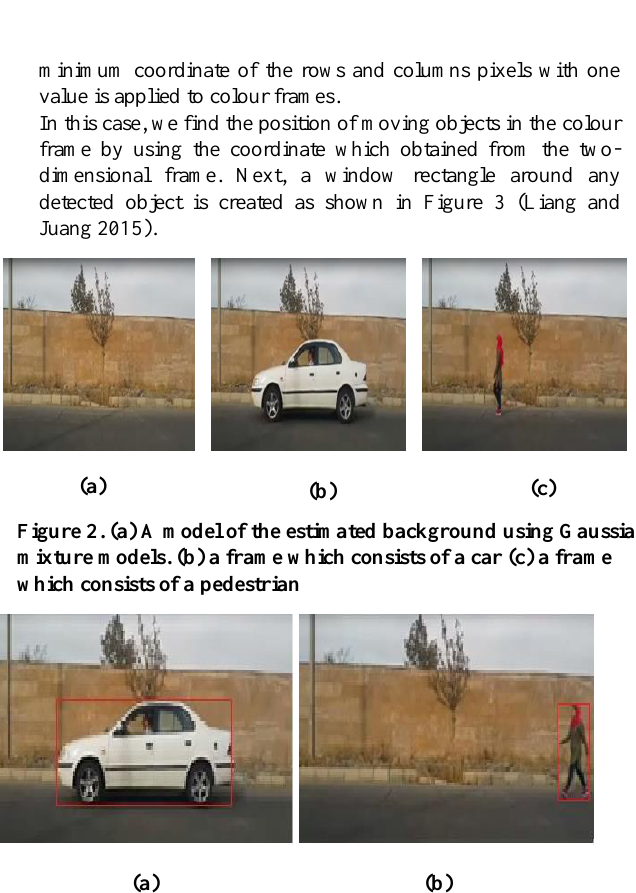
Figure 3. (a) Rectangular window created around the pedestrian (b)